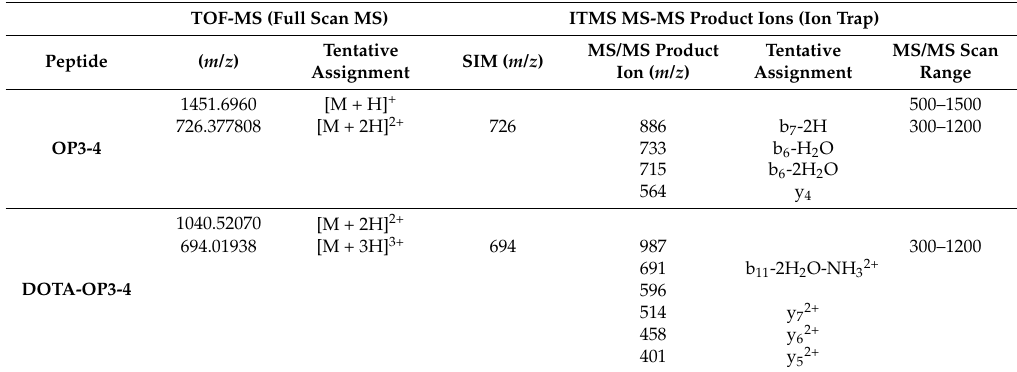
Table 1. Tandem MS of OP3-4 and DOTA-OP3-4 peptides using